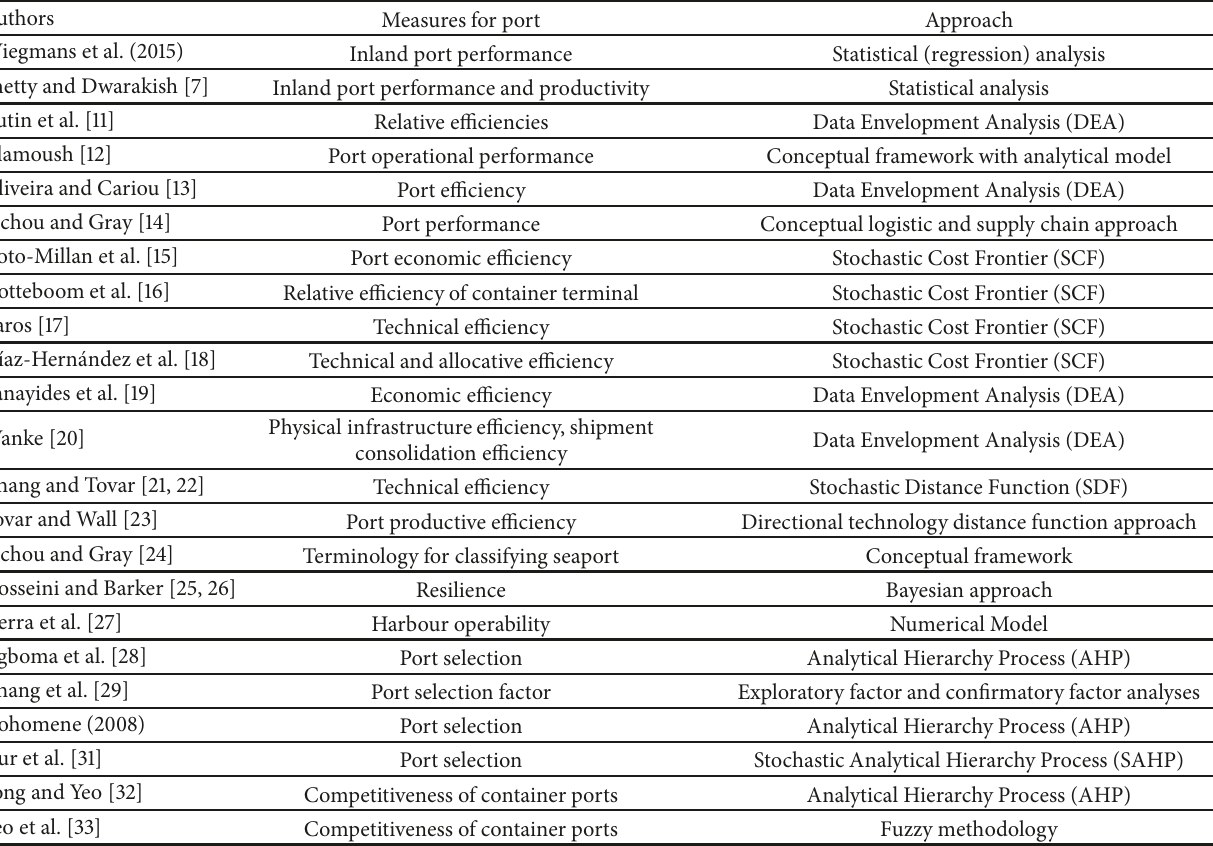
Table 1: Current themes of the port